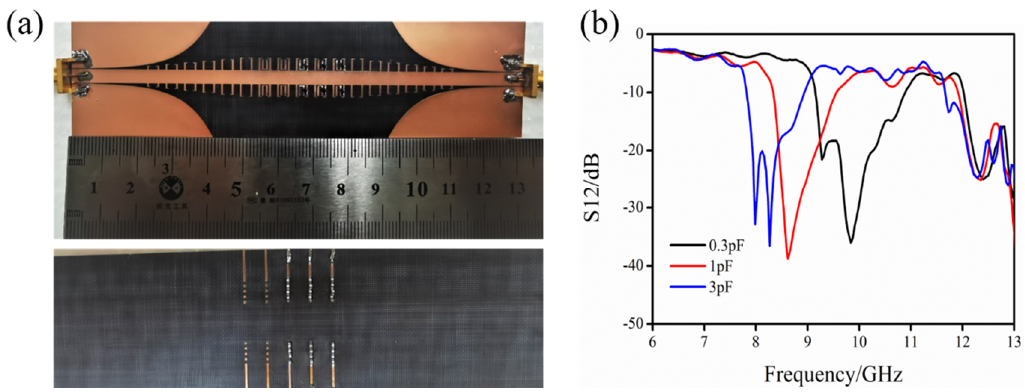
Figure 6. ( a )The picture of fabricated sample ( b ) Measured S-parameter under different capacitances.